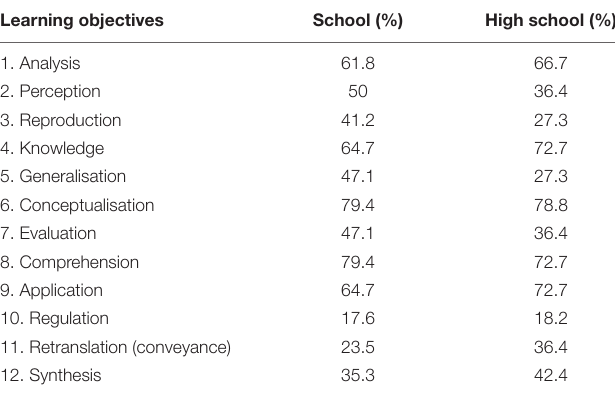
TABLE 3 | Importance of learning objectives, as viewed by the